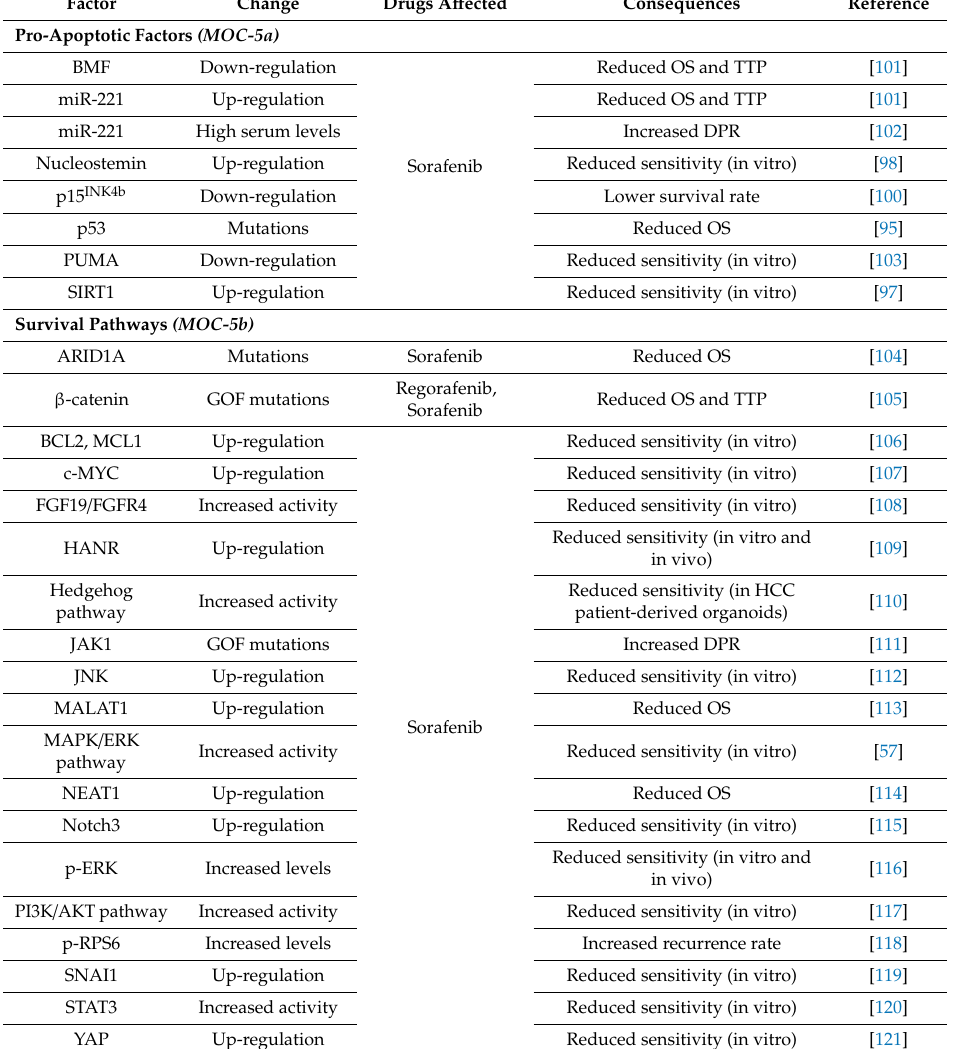
Table 3. Mechanisms of chemoresistance type 5 (MOC-5) to drugs clinically used in